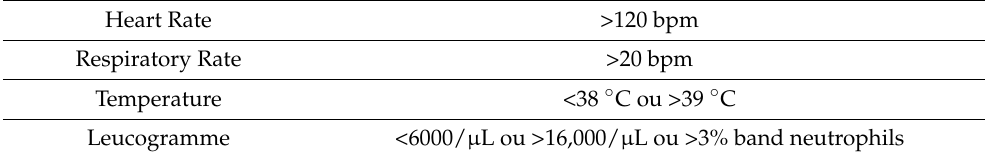
Table 2. Systemic inflammatory response syndrome diagnostic parameters.